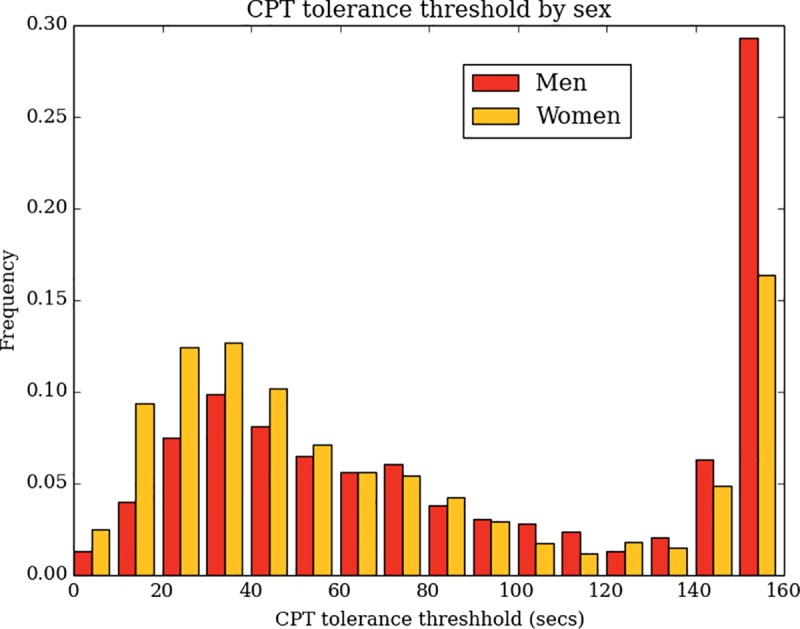
Distributions of CPT tolerance times by sex.